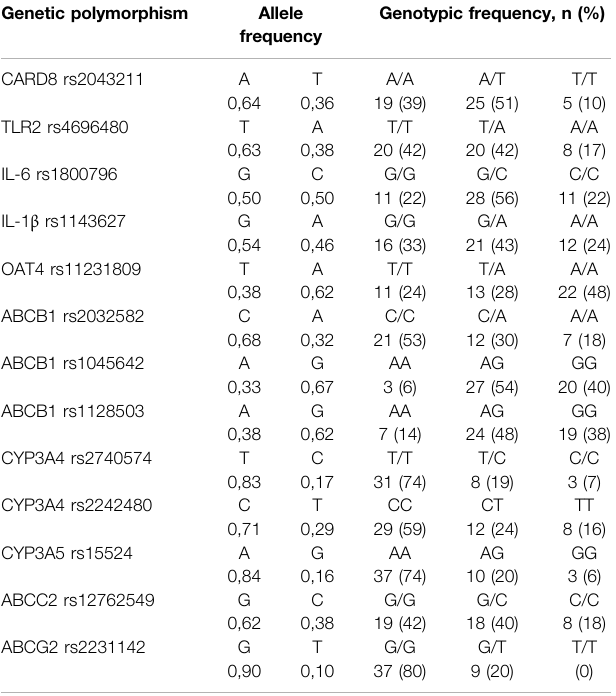
TABLE 2 | Allele and genotypic frequencies of the studied polymorphism. Genetic